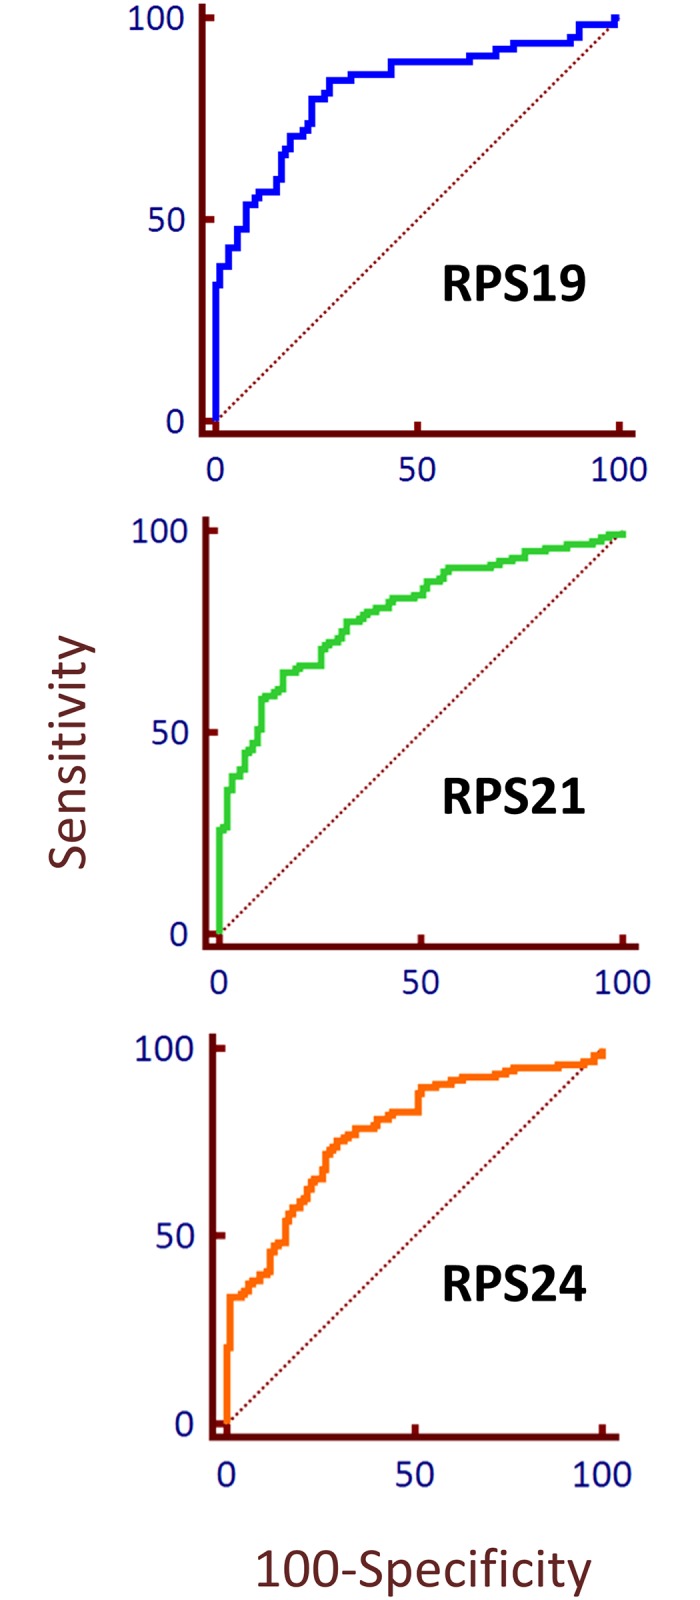
ROC of RPS19, RPS21, and RPS24 in prostate tissue.ROC curve to demonstrate the potential ability of a label to differentiate between malignant and non-malignant prostate tissue. The probit function was used for area fraction per amount of tissue for ROC analysis of RPS19, RPS21, and RPS24. The dotted line is representative of an area under the curve of 0.5 which shows no distinction between the two classifiers (e.g. normal vs malignant).